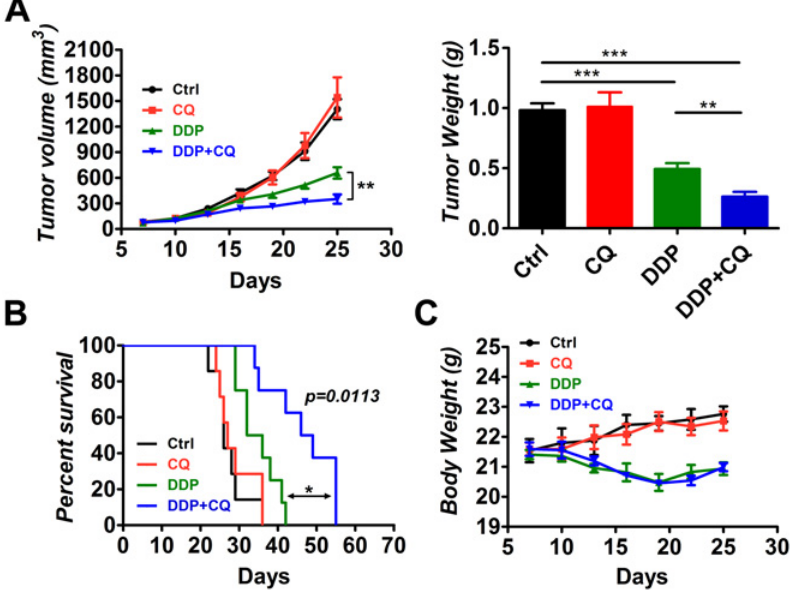
Fig 1. Chloroquine (CQ) enhances the efficacy of cisplatin (DDP) in xenograft tumors. Tumor-bearing mice (7 animals per group) were treated by intraperitoneal injection as follows: vehicle control, CQ (60 mg/kg/ day), DDP (5 mg/kg/6 days) and a combination of DDP and CQ for 18 days. (A) The tumor volume and tumor weight for each group. (B) Survival analysis of the treated mice in each group (n = 7). DDP+CQ led to a 15.5-day increase in the median survival compared with the mono-DDP treatment. (C) The body weight of mice during treatment. * p < 0.05, ** p < 0.01, *** p < 0.001.